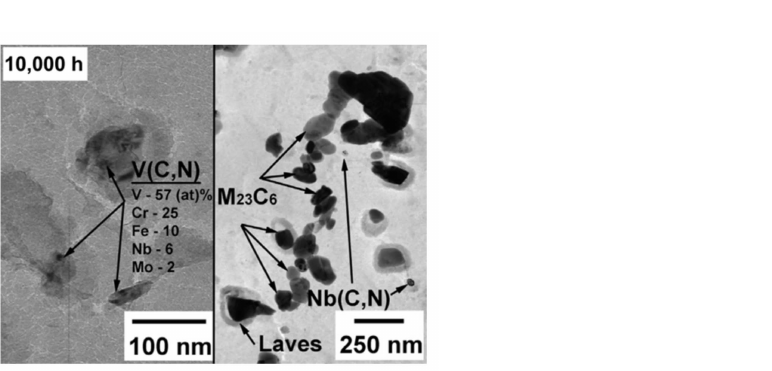
Figure 25. TEM micrograph (extraction replica) showing the precipitated fine V-rich M(C,N) particles at the apparent steady-state creep stage (10,000 h) in the 10Cr steel. Reprinted with permission from Ref. [15]. Copyright Elsevier